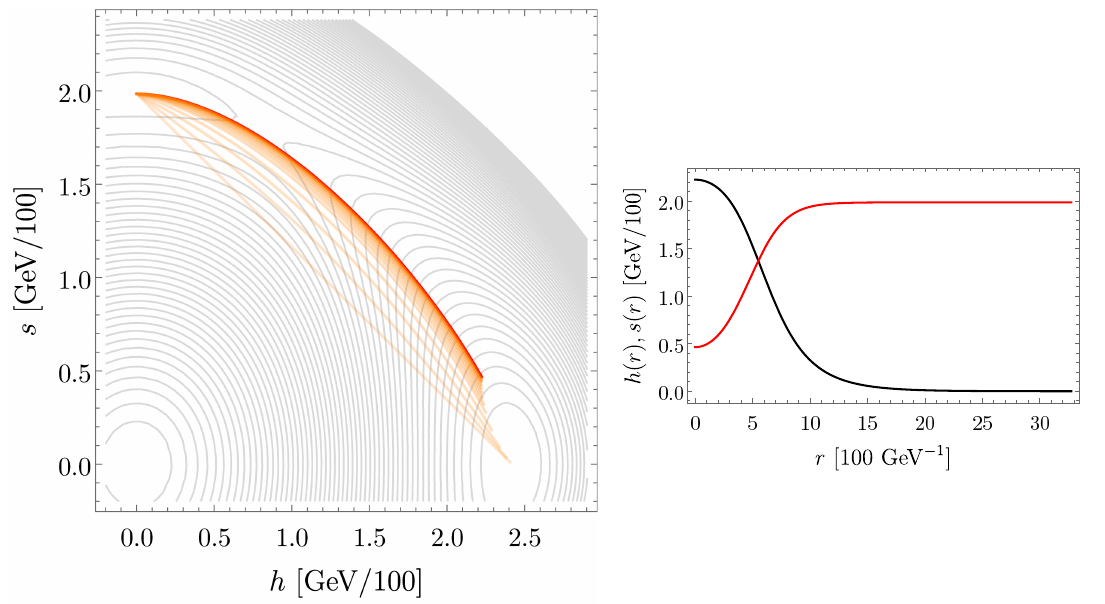
Figure 10 . Left : iterative procedure for the correct path, starting from the straight line connecting the two minima and then modified according to the field ~N . Right : bounce profile of the fields (black for h ( r ) and red for s ( r ) ) on the correct path.